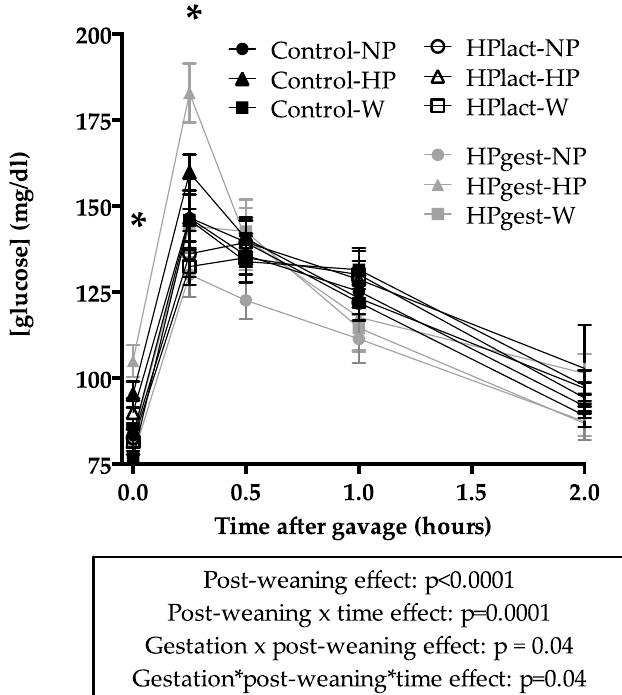
Figure 4. Blood glucose during an oral glucose tolerance test on female rat pups at PND68. Data are represented as means ± SEM, ( n = 8). Effects of diets, time and their interactions were tested within mixed Model 2. * post-weaning HP diet groups significantly different than the others.